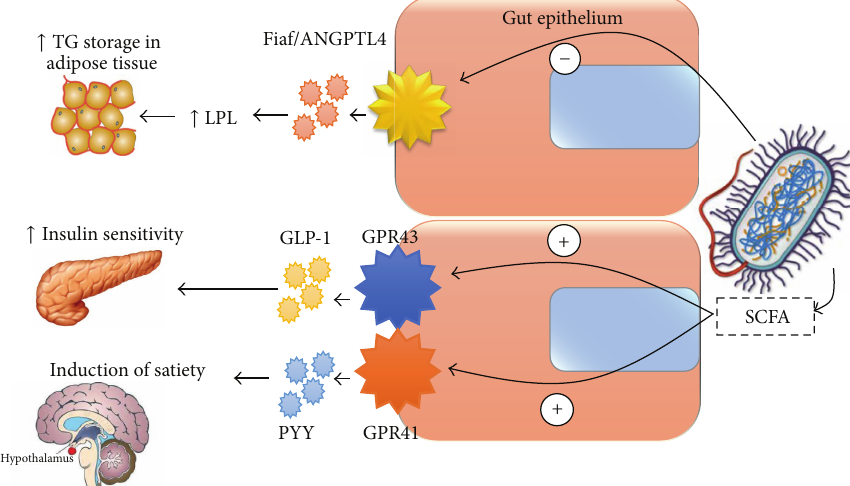
Figure 2: Proposed mechanism of the changes in gut hormonal axis by gut microbiota. TG: triglycerides, LPL: lipoprotein lipase, Fiaf: fasting induced adipocyte factor, ANGPTL-4: angiopoitein-like protein-4, GLP-1: glucagon like peptide-1, GPR43 and GPR41: G protein coupled receptors 43 and 41, PYY: peptide YY, and SCFA: short chain fatty acids. Minus sign indicates inhibitory effect; plus sign indicates stimulatory